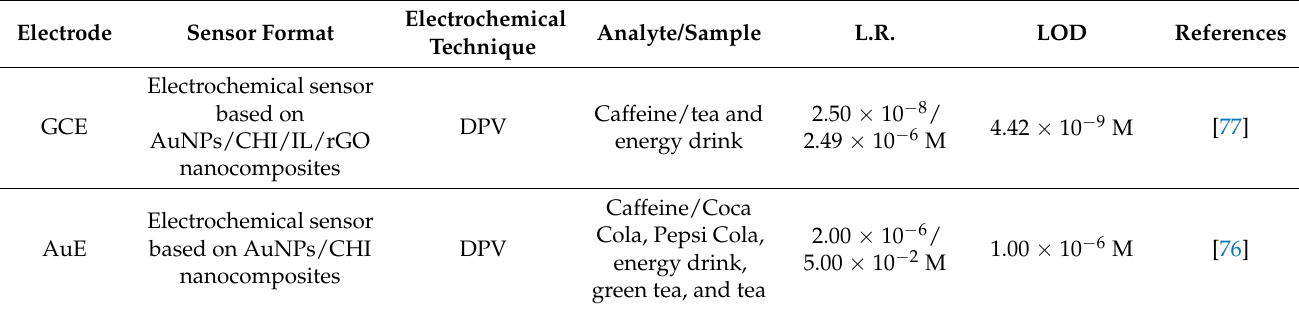
Table 2. Recent examples of CHI-based electrochemical sensors for caffeine